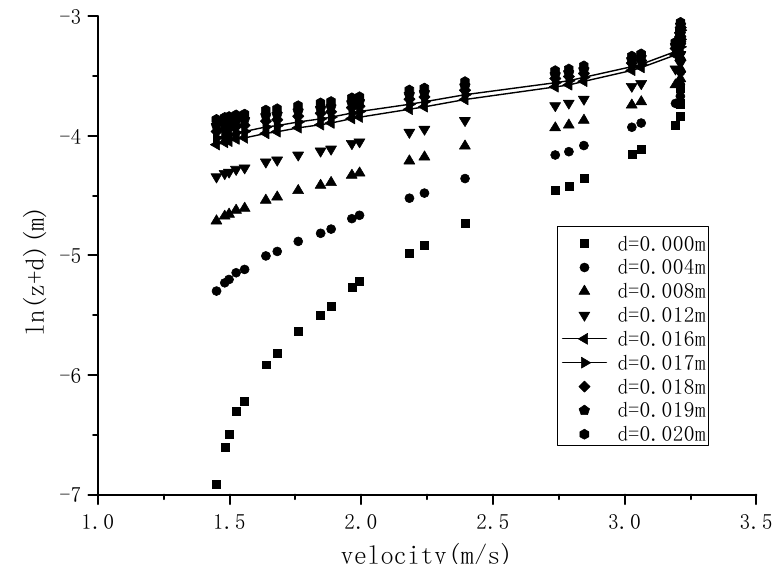
Figure 2. Determination the displacement height d under one of the typical velocity profiles in the nonaerated skimming flow zone on a stepped spillway.